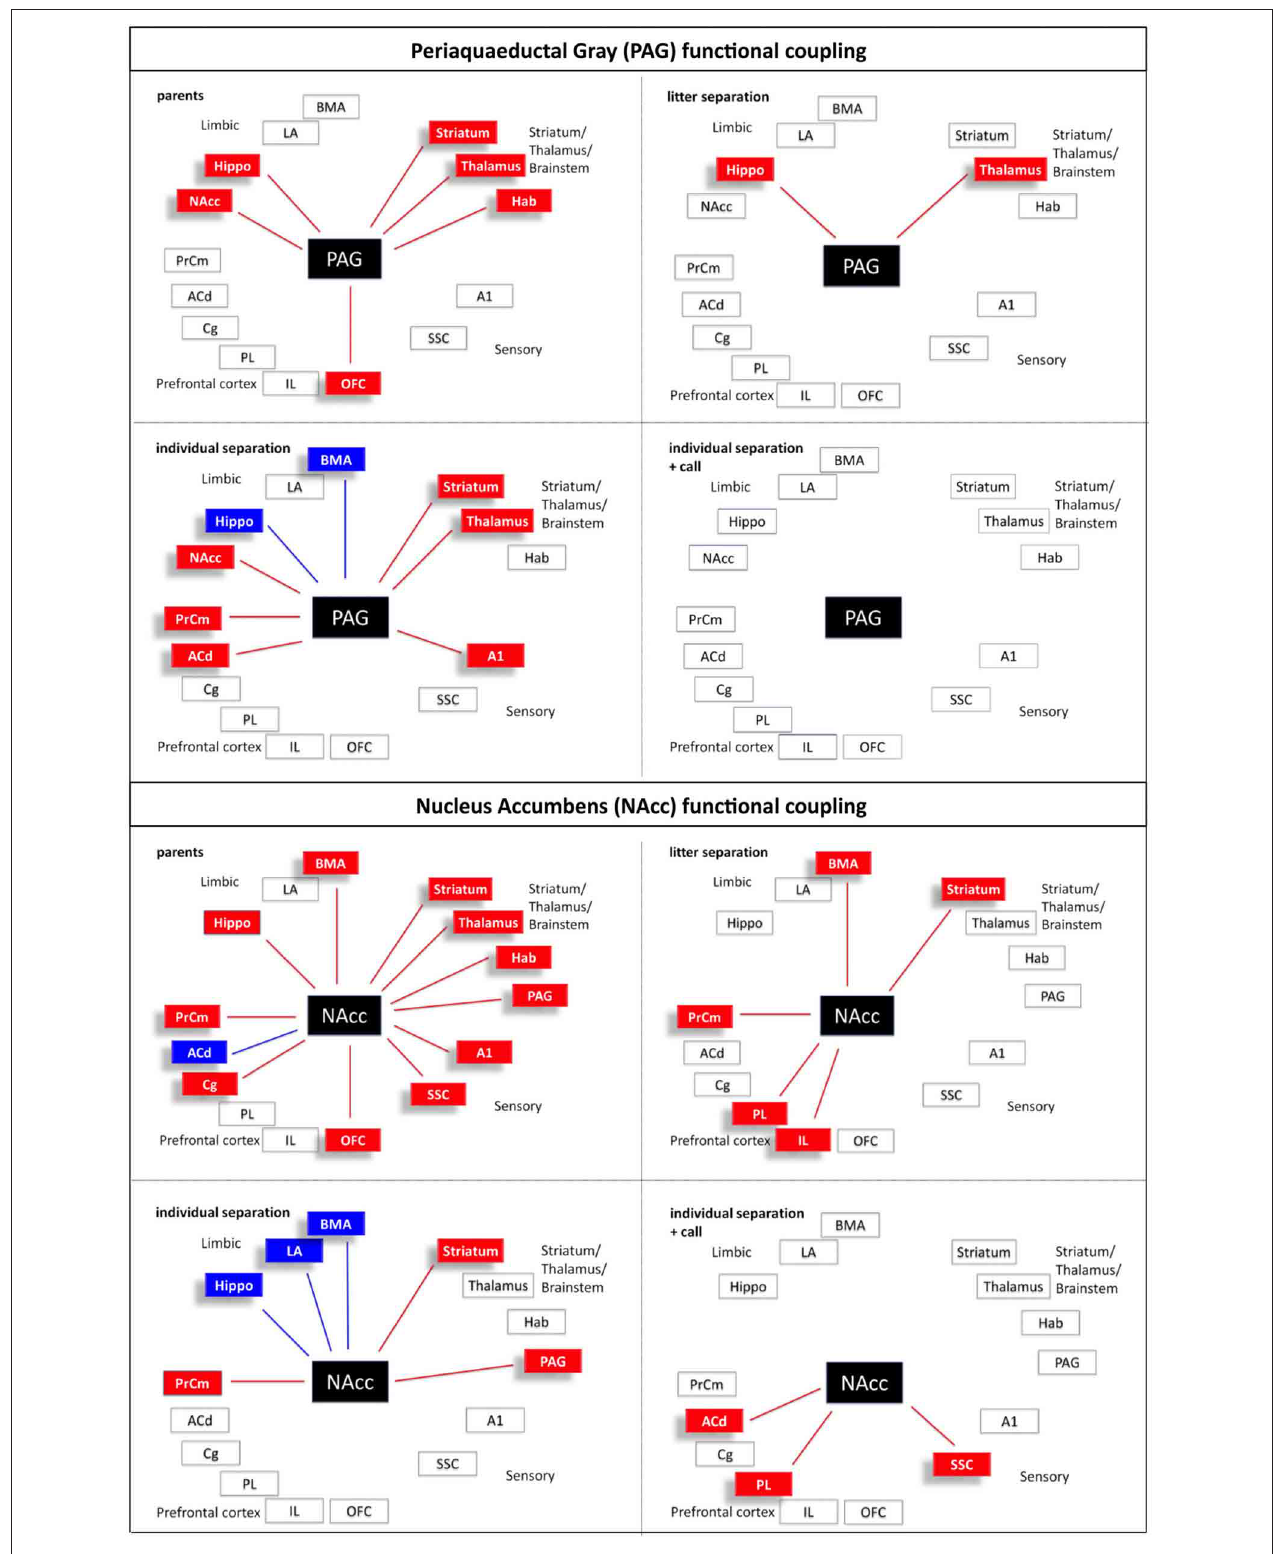
FIGURE 10 | Interregional functional coupling of the periaqueductal gray (PAG) and nucleus accumbens (NAcc) under different stress conditions. Red color indicates positive, blue color indicates negative correlations ( p < 0 . 05).